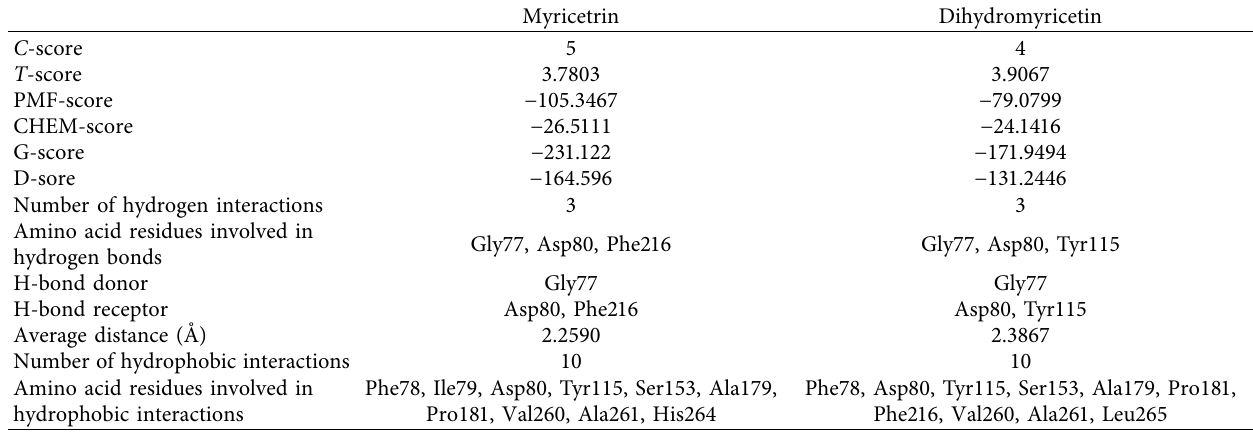
Table 4: Docking parameters, hydrogen bonds, and hydrophobic interactions observed between flavonoids and pancreatic lipase from molecular docking simulation